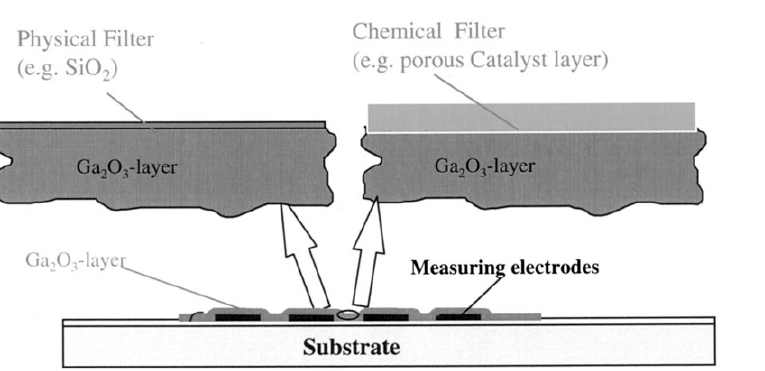
Figure 17. Conceptual diagrams for physical and chemical filters of Ga 2 O 3 ‐ based gas sensors [230]. Copyright 1998 Elsevier.